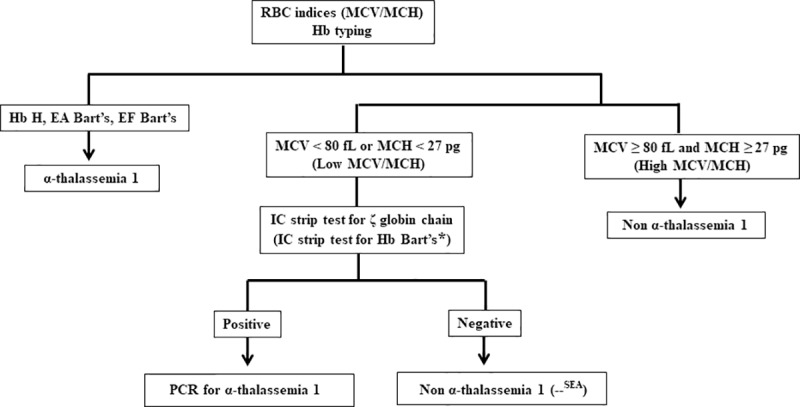
A proposed α0-thalassemia screening strategy.The hematologic analysis, including MCV/MCH and Hb typing, are first performed for each blood sample. Notably, the Hb typing is not necessary in screening of α0-thalassemia traits only. Samples with high MCV and MCH values are ruled out as α0-thalassemia carriers. The IC strip test for ζ-globin chains (and IC strip test for Hb Bart’s) is subsequently performed using samples with low MCV or MCH values. The IC strip test negative samples can be ruled out for α0-thalassemia (--SEA). The positive samples are then subjected to α0-thalassemia genotyping by PCR. The samples identified as Hb H, EA Bart’s (Hb H disease with Hb E trait) and EF Bart’s diseases (Hb H disease with β0-thalassemia/Hb E or Hb H disease with homozygous Hb E) do not need to be assayed using the IC strip test assay. Samples with a non-SEA deletion type (α0-thalassemia (--THAI)) will test negative using the IC strip test for ζ-globin chains. To identify this type of α0-thalassemia, an IC strip test for Hb Bart’s is required. * To determine or differentiate α0-thalassemia (--THAI) and α0-thalassemia (--SEA), an IC strip test for Hb Bart’s is required.